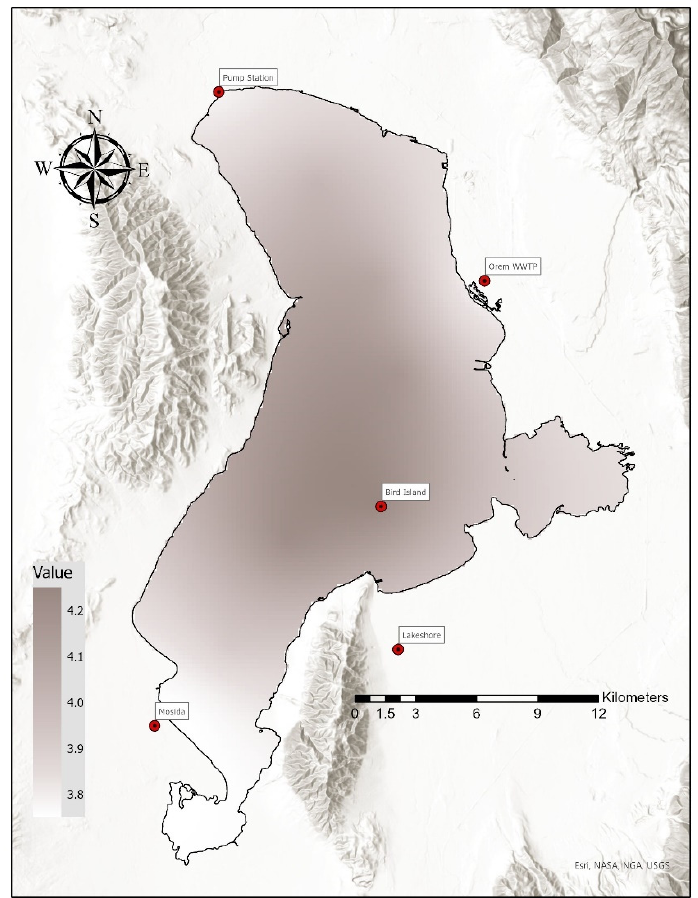
Figure 14. Interpolated DIN AD results on 23 August 2020, using the five sampler locations including the Bird Island in the lake interior. For this week, Bird Island and Lakeshore had similar values, while the other stations were lower.